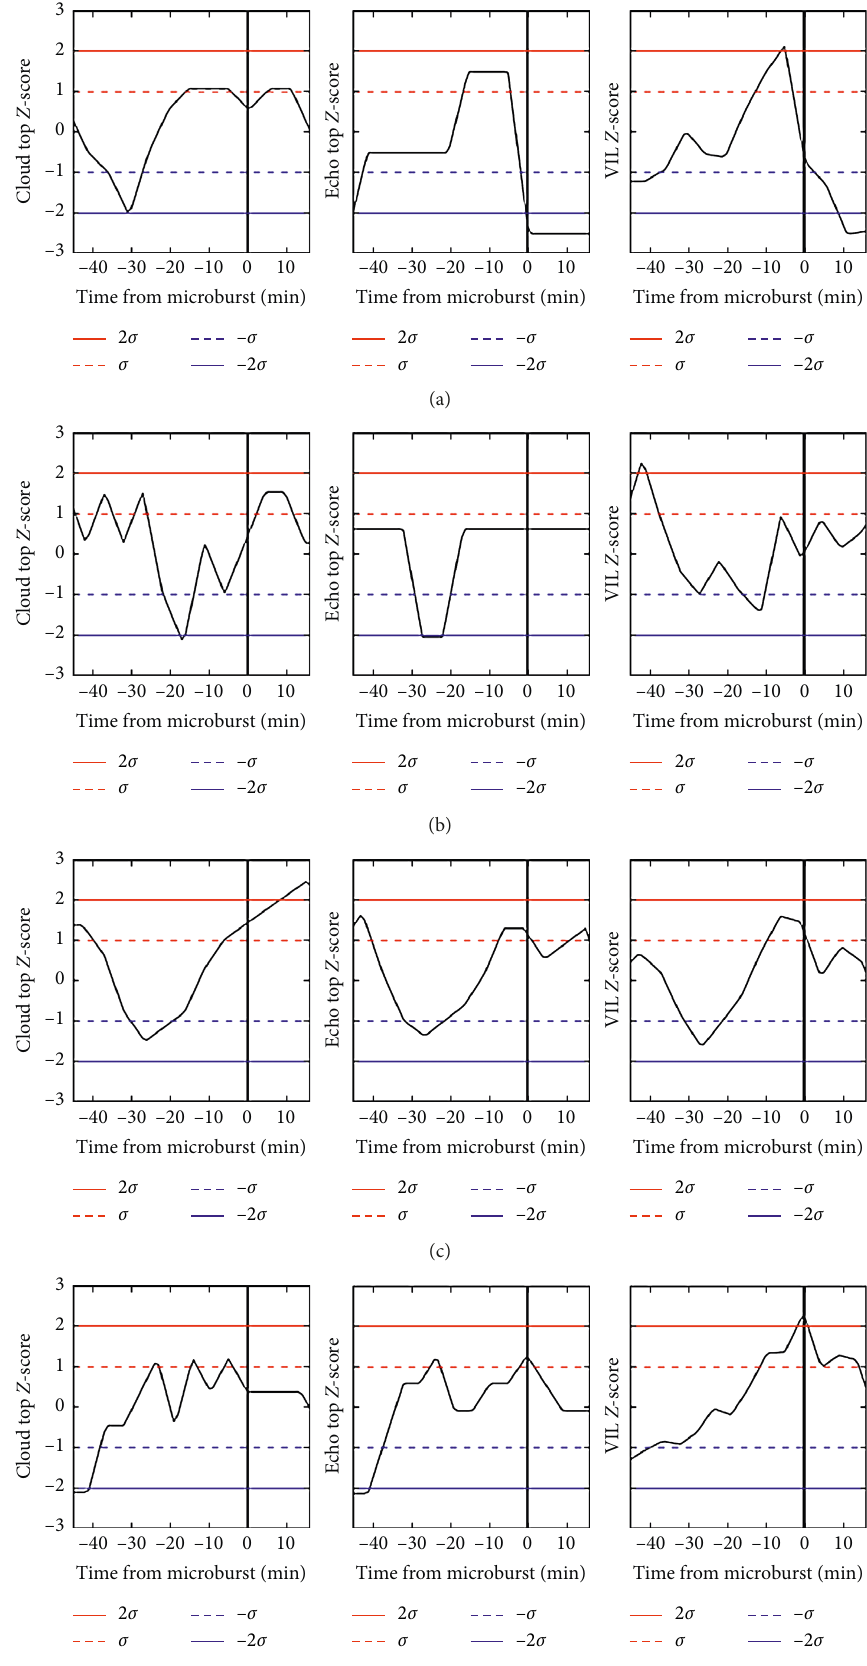
Figure 10: As in Figure 9, except for the next four cases. (a) 20140708PA microburst. (b) 20150612 microburst. (c) 20150623 microburst. (d) 20150630